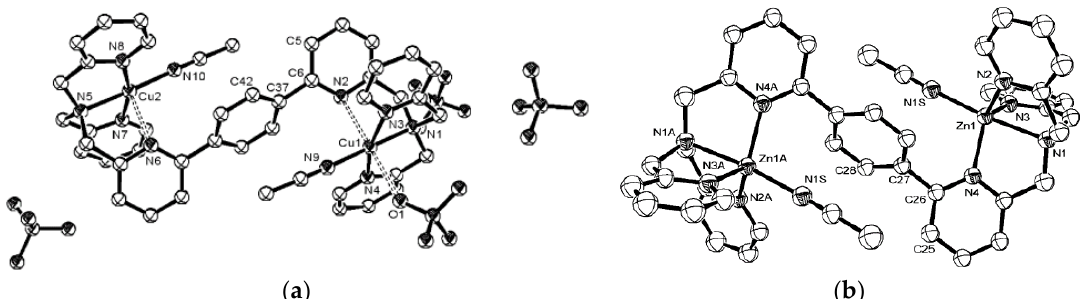
Figure 2. X-ray crystal structure of the Zn 2+ ( a ) and Cu 2+ ( b ) complexes of PBTPA. Reprinted with permission from Reference [28]. Copyright (2003) American Chemical Society.